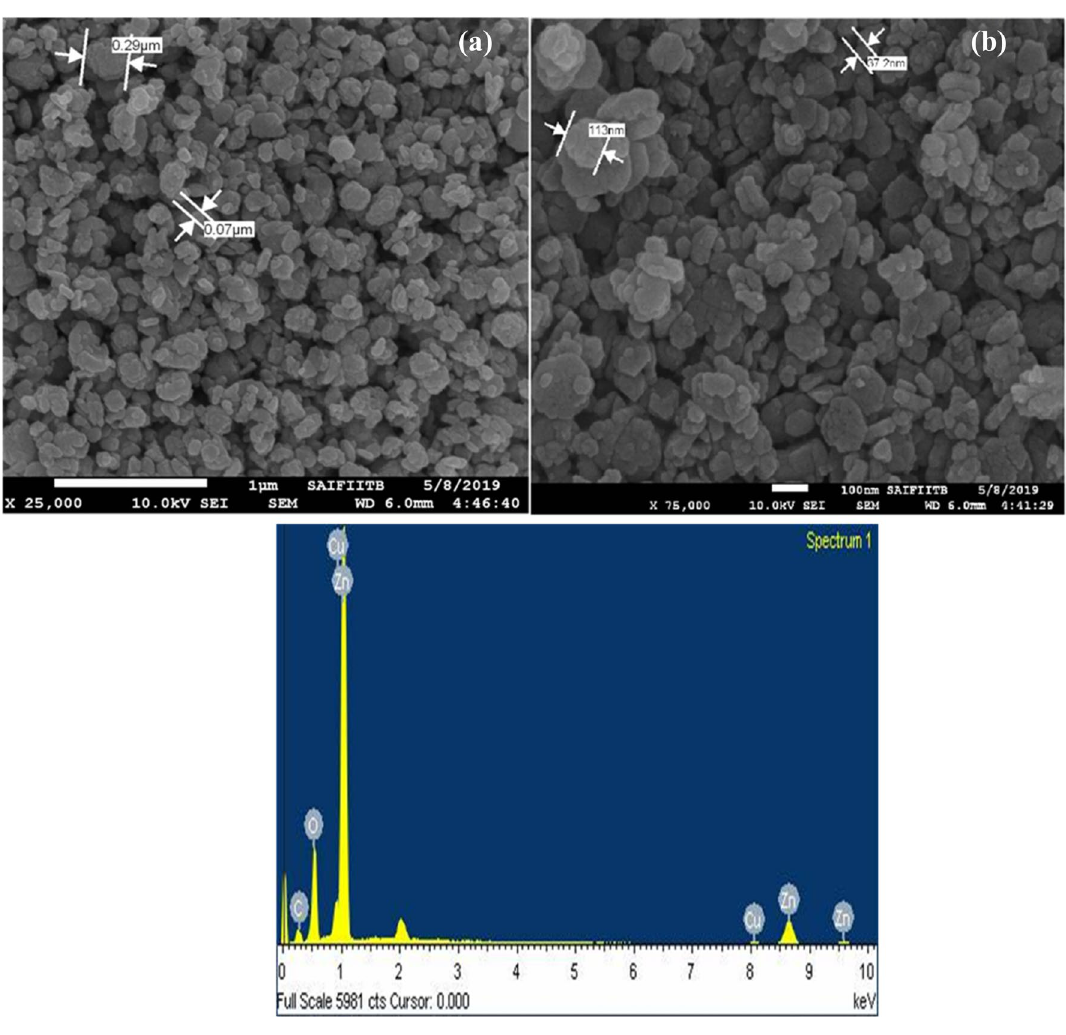
Fig. 10 FEG-SEM and EDAX of ZnO